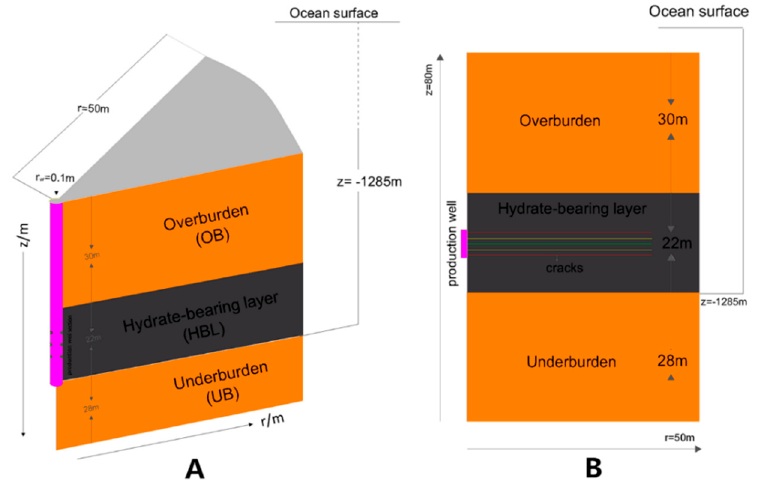
Figure 2. ( A ) Design of the production well, and ( B ) diagram of the horizontal stimulation cracks.